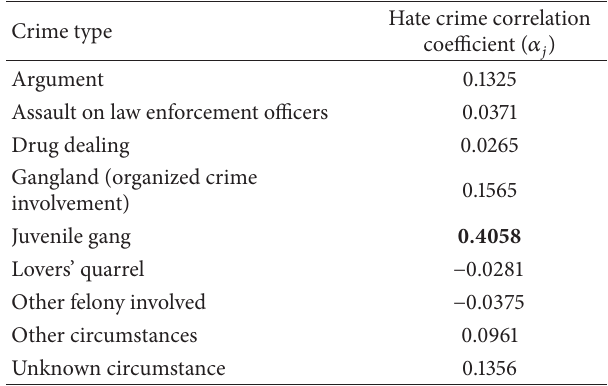
Table 4: Likelihood index and clustering for hate